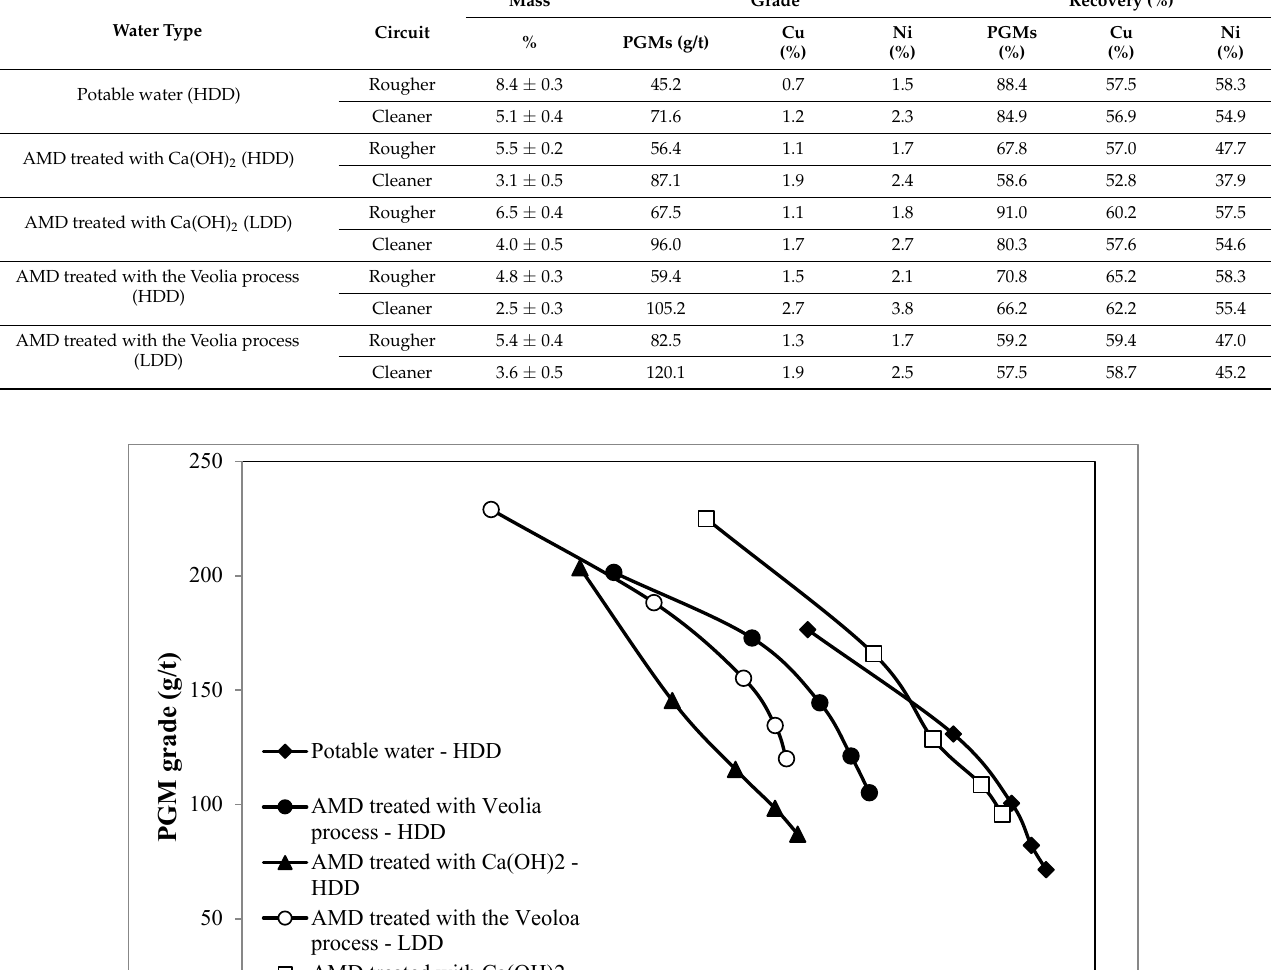
Table 6. Effect of water type and depressant dosage on the flotation response of the Merensky ore. LDD = 25 g/t; HDD = 50 g/t.